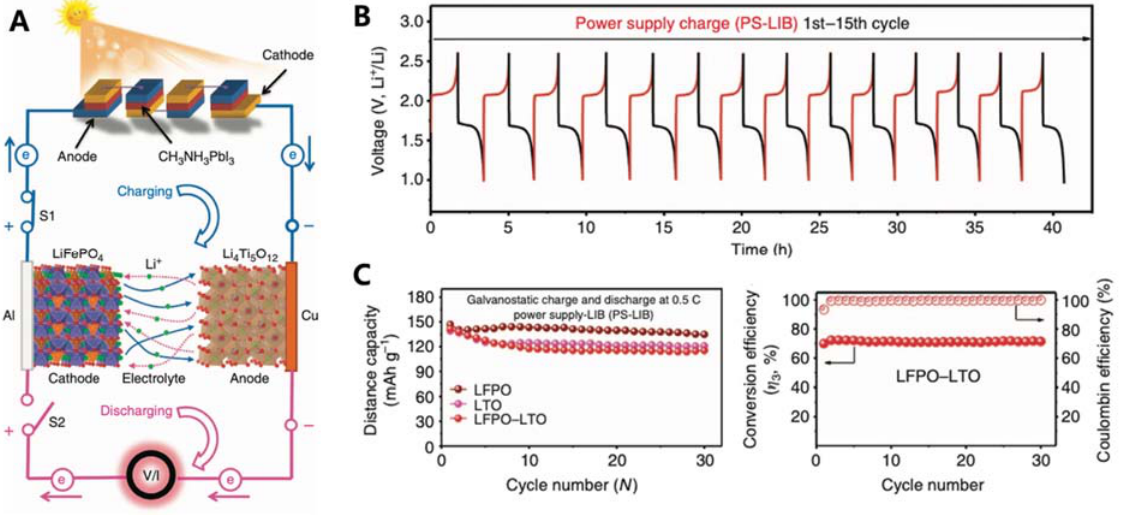
Figure 7. ( A ) Schematic of a fabricated system of LIB photo-charging by PSCs. ( B ) V–t curves of a fresh LIB cell measured at 0.5 C in the voltage range of 1.0–2.6 V for 15 cycles. ( C ) Cycling performance of different types of LIB cells measured at 0.5 C in the voltage ranges of 1.0–3.0, 2.5–4.0 and 1.0–2.6 V for 30 cycles. Reprinted with permission from ref. [54] Copyright 2015, the Nature Publishing Group.